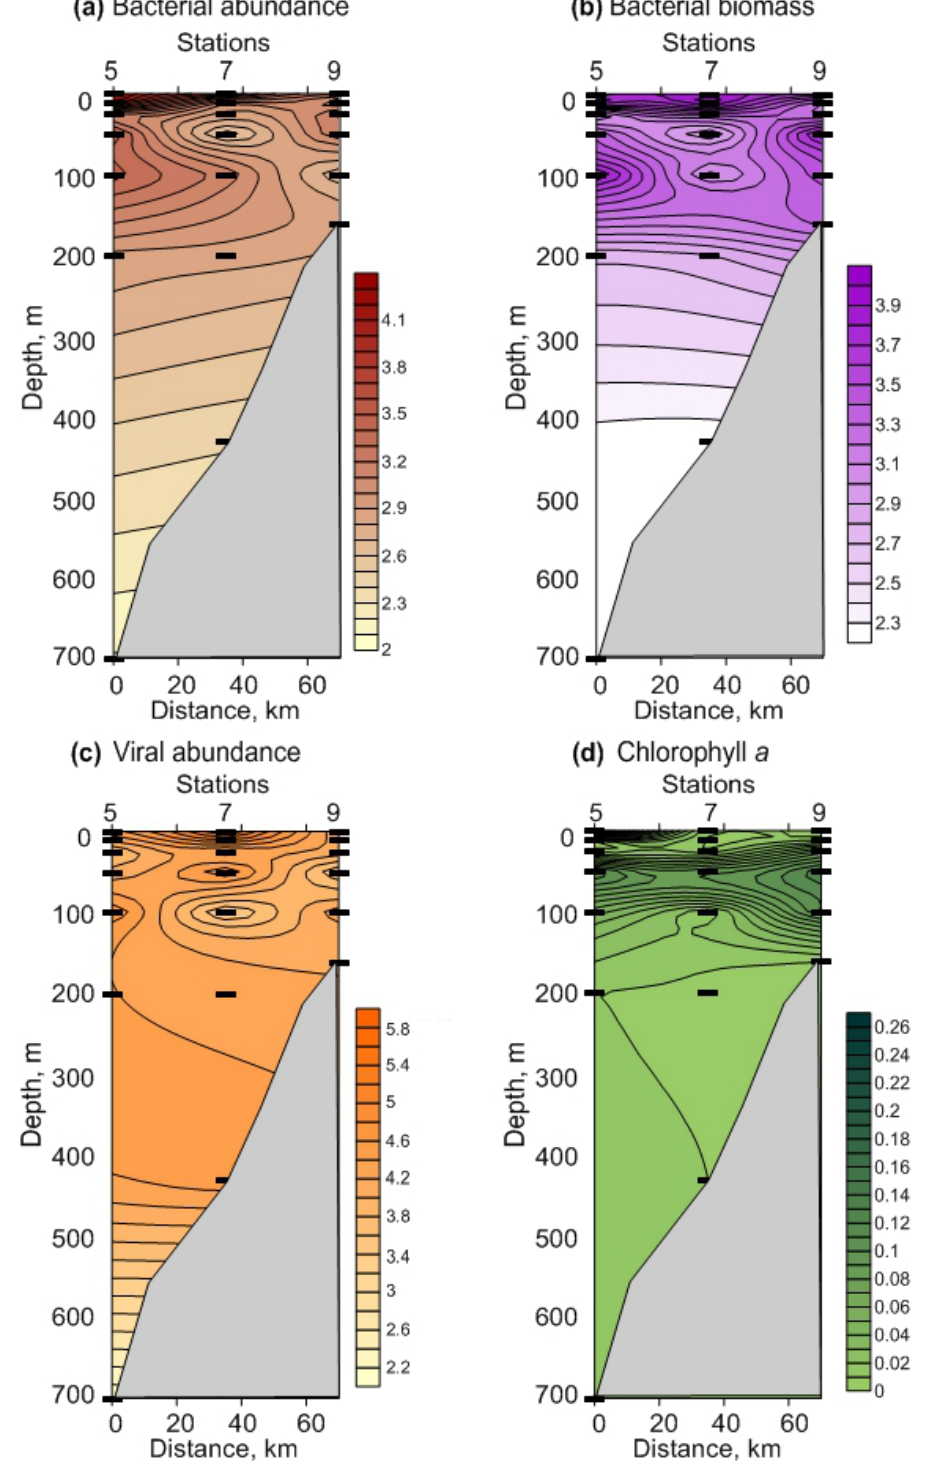
Figure 4. Vertical profiles of bacterial abundance, 10 5 cells mL − 1 ( a ), bacterial biomass, mg C m − 3 ( b ), viral abundance, 106 particles mL − 1 ( c ), and chlorophyll a , mg m − 3 ( d ) in the Fram Strait, winter